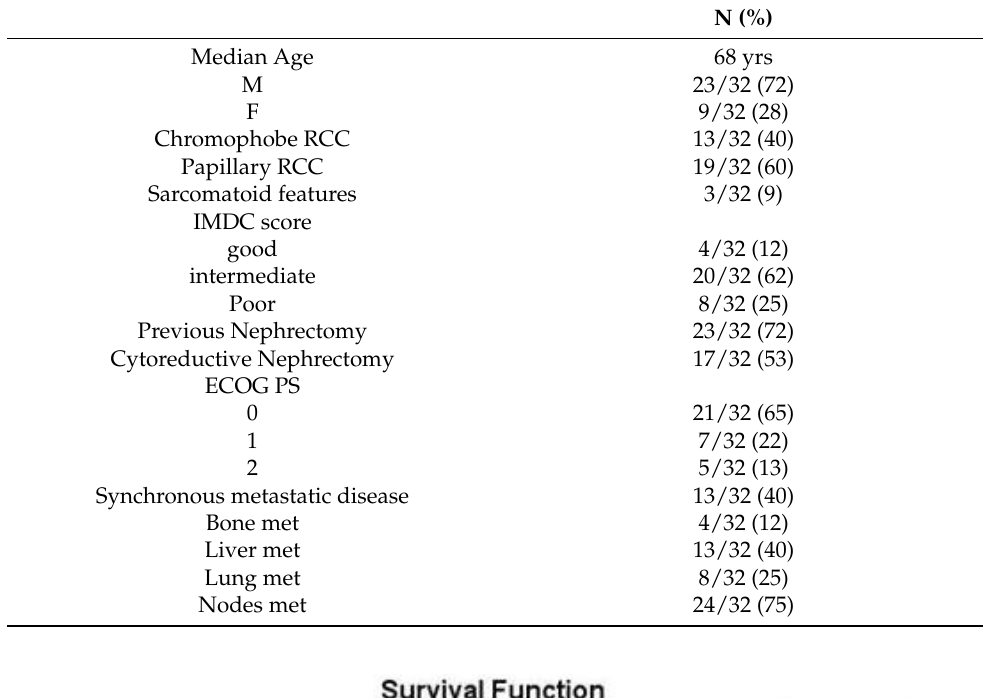
Table 1. Characteristics of patients. IMDC (International Metastatic RCC Database Consortium); ECOG PS (Eastern Cooperative Oncology Group Performance Status); yrs (years); met (metastasis).